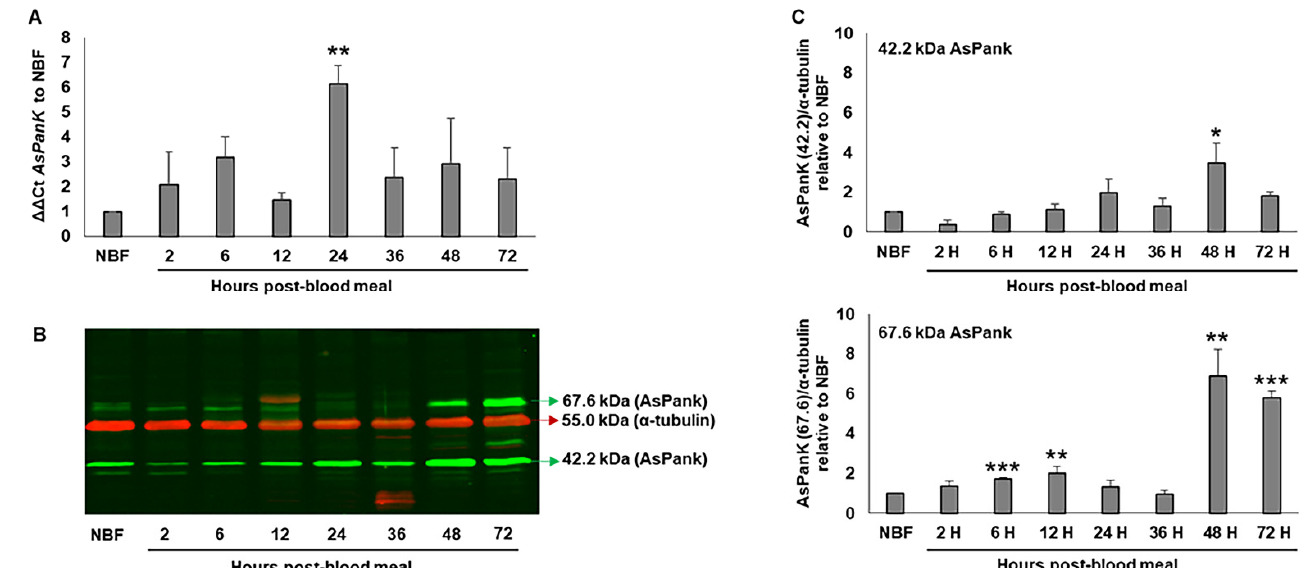
Figure 1. A. stephensi PanK transcript and protein levels in the midgut throughout a reproductive cycle. ( A ). A. stephensi PanK ( AsPanK ) transcript levels prior to (NBF) and following (2–72 h) a blood meal relative to a ribosomal S17 internal control. Error bars represent the standard error of the mean. Differences among respective timepoints were evaluated using one-way ANOVA with Tukey’s post hoc test. Three biological replicates with distinct cohorts of mosquitoes (ten mosquito midguts pooled per replicate) were performed. ( B ). Representative immunoblot showing changes in mosquito midgut PanK proteins prior to and during a reproductive cycle. α -tubulin antibody was used to assess loading. Three biological replicates with distinct cohorts of mosquitoes were performed and each lane represents one midgut equivalent from pools of ten mosquito midguts. ( C ). Densitometry analysis of the putative A. stephensi 42.2 and 67.6 kDa PanK isoforms from replicate immunoblots. Bars represent the density ratios of the respective PanK isoforms relative to α -tubulin. Error bars represent the standard error of the mean. Differences among respective timepoints compared to NBF were evaluated using one-way ANOVA with Tukey’s post hoc test. p -values: *** p < 0.001, ** p < 0.01, and * p < 0.05.